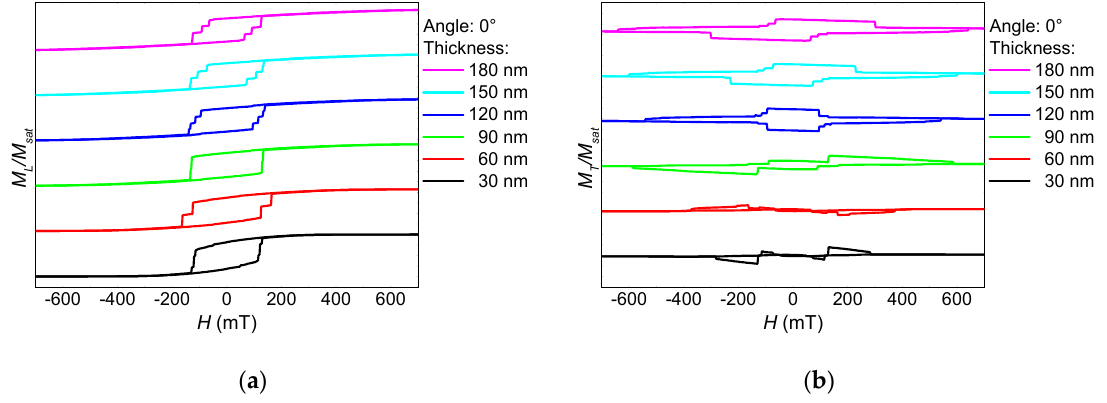
Figure 2. Thickness dependence of ( a ) the longitudinal and ( b ) the transverse hysteresis loops, simulated for sample NF1 under an angle of 0°.